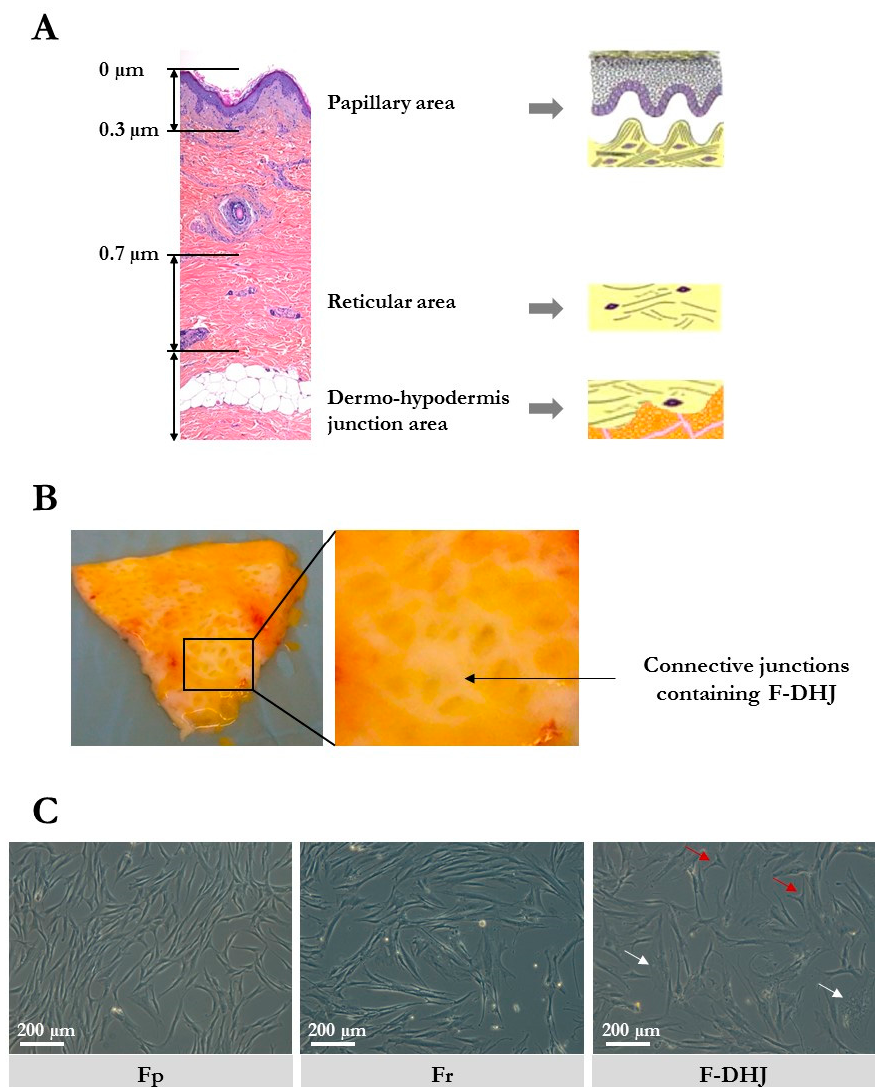
Figure 1. Skin localization and cellular morphology of papillary dermis fibroblasts (Fp), reticular dermis fibroblasts (Fr), and dermo-hypodermal junction (DHJ) fibroblasts. ( A ) Representation of the papillary dermis, reticular dermis, and dermo-hypodermis junction areas. A typical full-thickness skin section is shown, as well as schemes of the three areas of interest. ( B ) Photographs of skin pieces taken from the below side after fat tissue removal, showing the macroscopic aspect of the conjunctival junctions that connect the dermis to the hypodermis. ( C ) Cellular morphology of cultured Fp, Fr, and DHJ fibroblasts. In F-DHJ cultures, red arrows point to small tricuspid cells and white arrows to large cells with a visible trabecular cytoplasmic